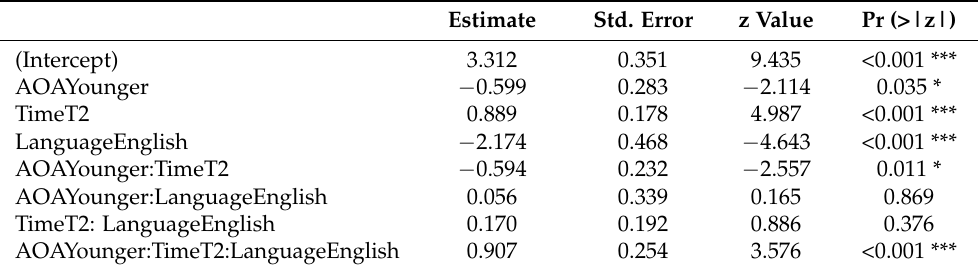
Table A6. Coefficients of the fixed effects of the logistic mixed-effects regression comparing perfor- mance in English and Arabic at T1 and T2 for the two AOA subgroups.